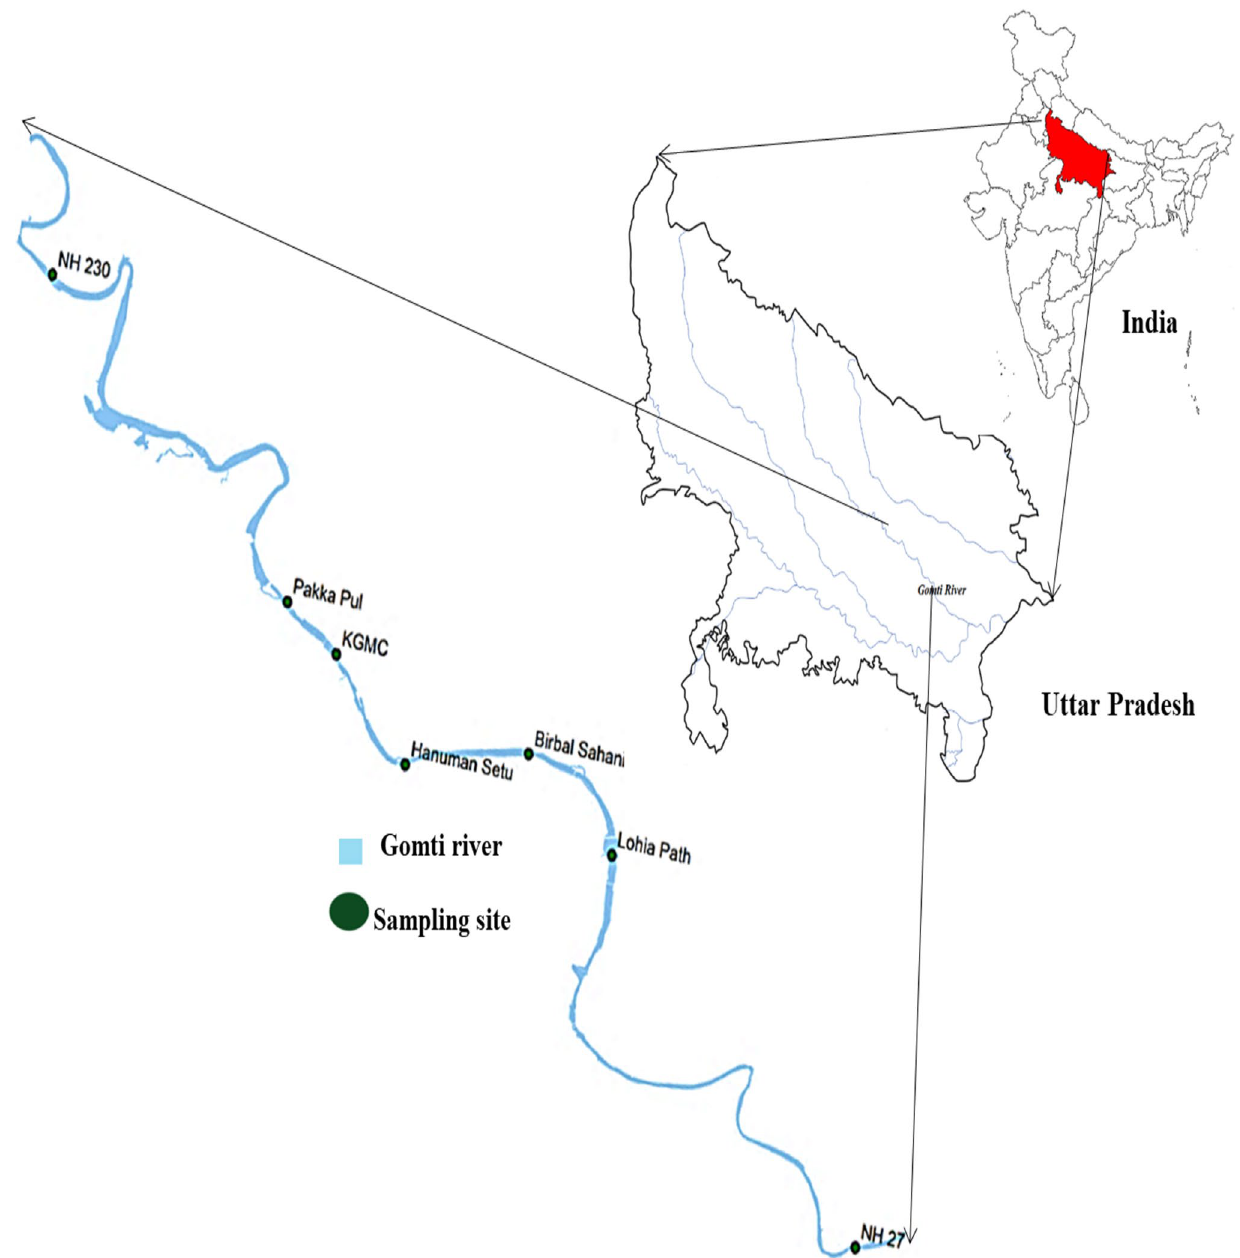
Fig. 1 Study area with location of sampling sites of Gomti River in Lucknow City, Uttar Pradesh,